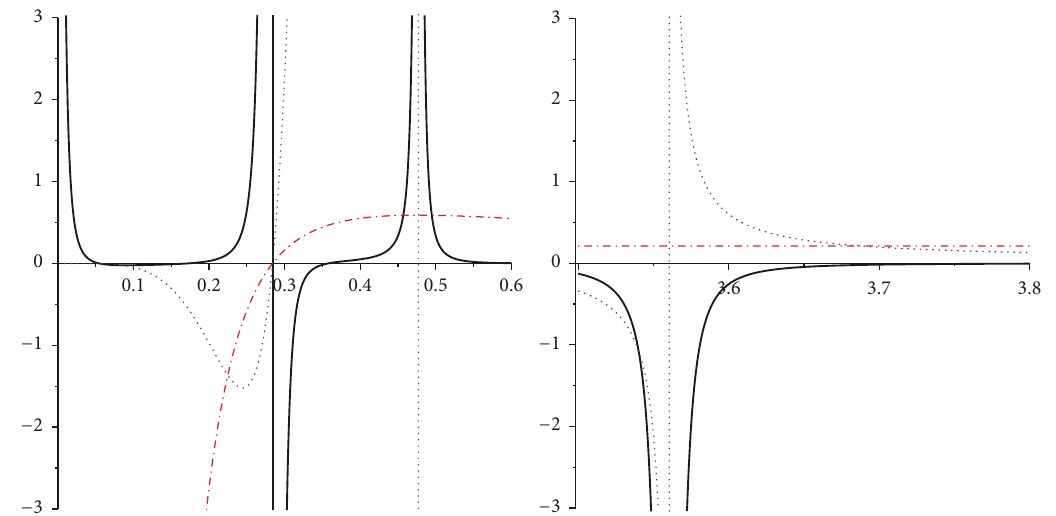
Figure 6: HPEM metric. R (continuous line), 𝐶 𝑄 (dotted line), and 𝑇 (dot dashed) versus 𝑟 + for Λ = −1 , 𝑛 = 6 , 𝑞 = 0.1 , 𝑏 = 1 , 𝜔 = 10 , and 𝛽 = 1.5 . “Note: both panels are plotted with the same parameters, but different regions and scales.”